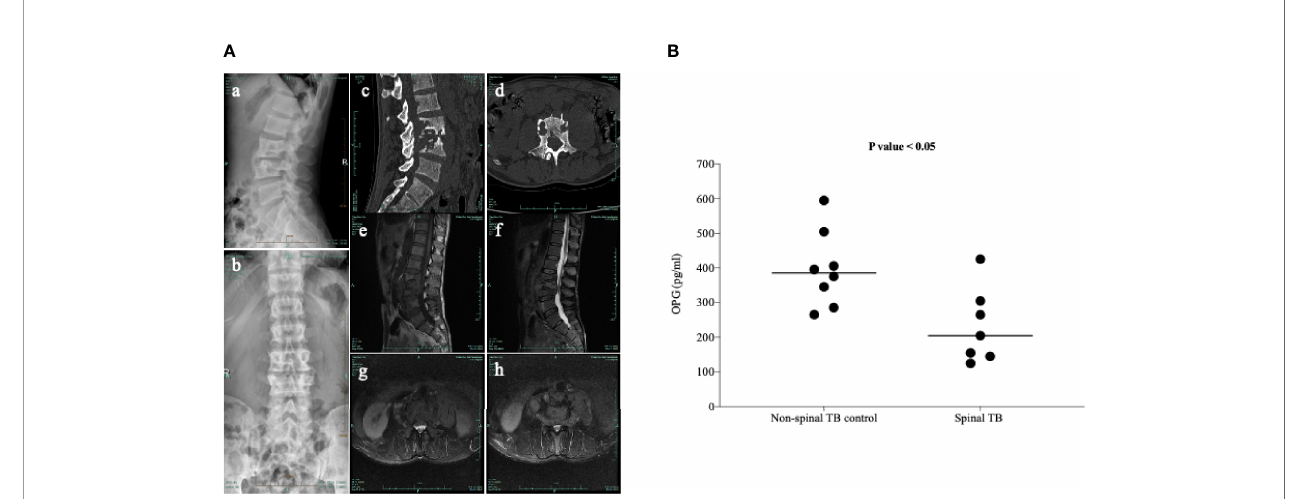
FIGURE 1 | Typical clinical manifestations of spinal TB in the study participants. (A) Typical radiology of a patient with spinal TB used in this study. ( a , b ) X-ray front and side positions suggesting the destruction of lumbar 3 and 4 vertebral bodies. ( c , d ) CT sagittal view showing bone destruction in the lumbar 2, 3, and 4 vertebrae. The CT axis showed severe damage to the vertebral body. ( e – h ) T1 and T2 images and axial position of MRI indicating bone destruction of the lumbar 2, 3, and 4 vertebrae, accompanied by paravertebral abscess formation. (B) Measurement of the circulating OPG levels in patients with spinal TB using a commercially available ELISA kit. Means without a common letter differ. p <